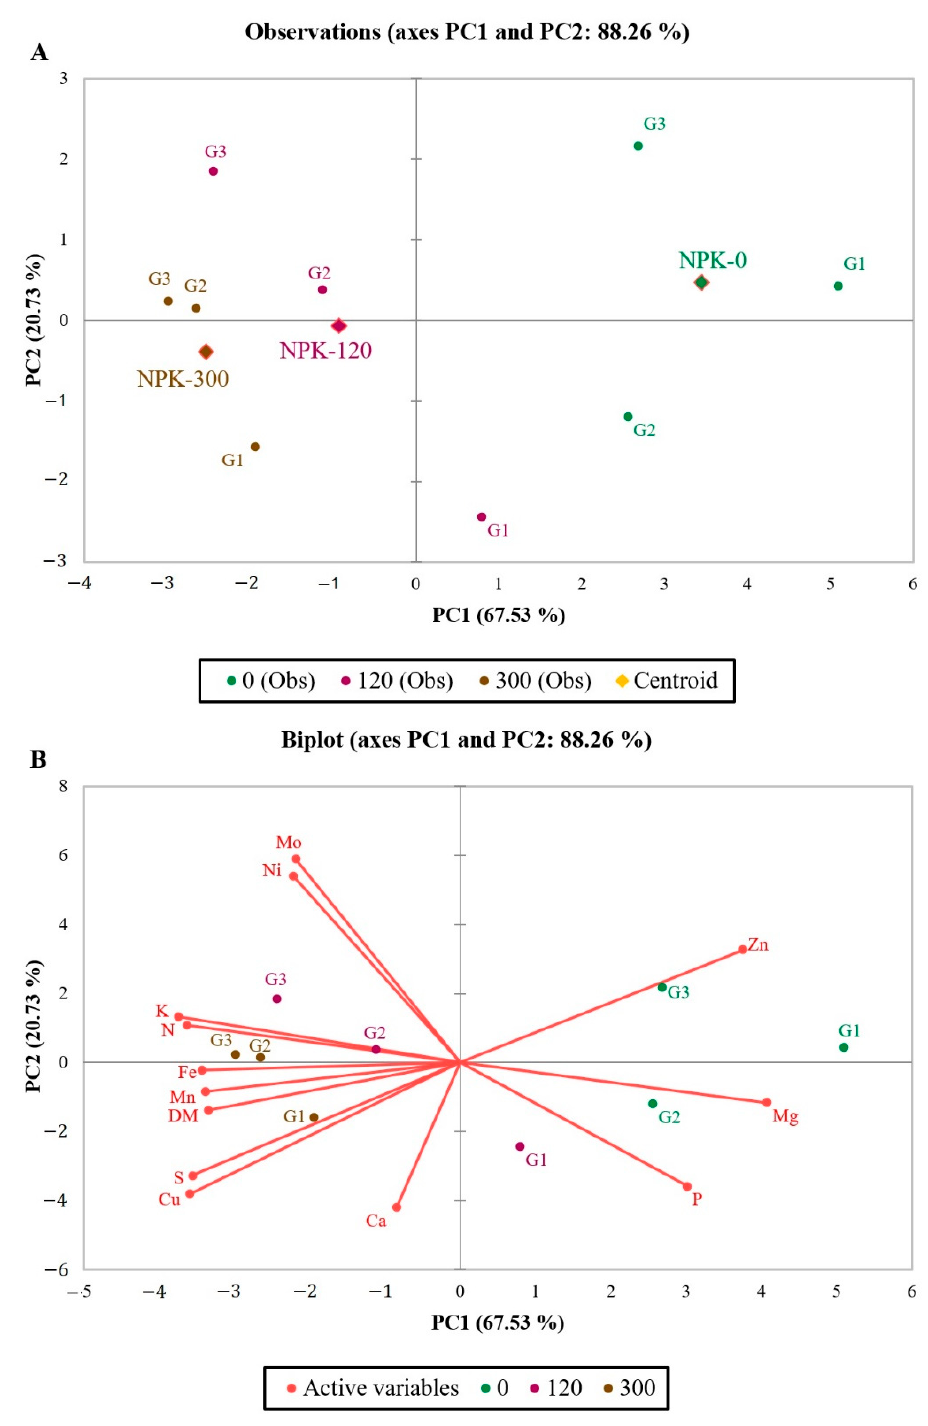
Figure 2. Principal component analysis (PCA) observation plot ( A ) and biplot ( B ) of the first two components performed on dry matter production and nutrient composition of maize genotypes affected by fertilizer levels. Centroids showing segregation of maize genotypes. (G1: FAO 420; G2: FAO 490; G3: FAO 390). (N (nitrogen), P (phosphorus), DM (dry matter), K (potassium), Mn (manganese), S (sulphur), Mo (molybdenum), Mg (magnesium), Ca (calcium), Fe (iron), Cu (copper), Ni (nickel)).